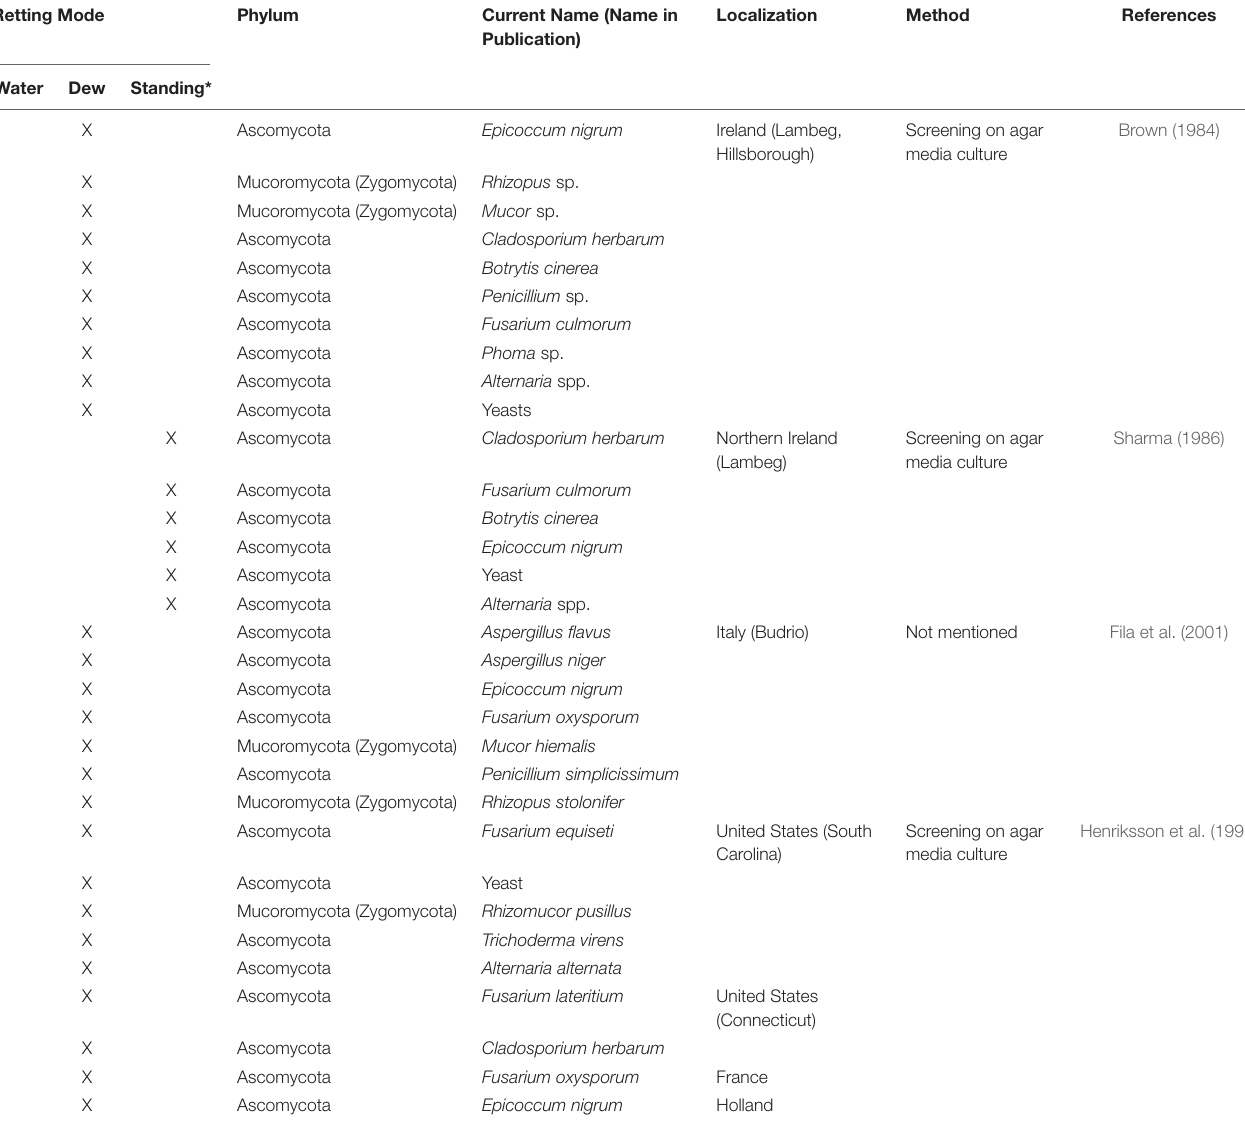
TABLE 2 | List of different fungal species involved in flax retting and identified by classical